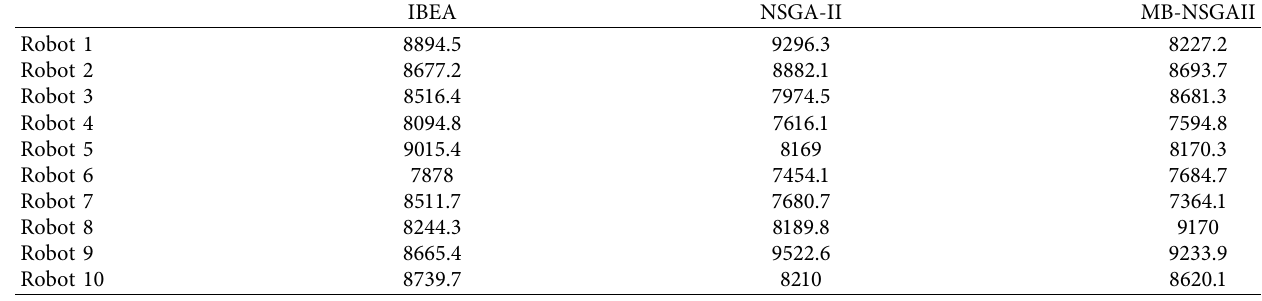
Table 9: Average time consumption of robots when using 10 robots for 500 tasks.